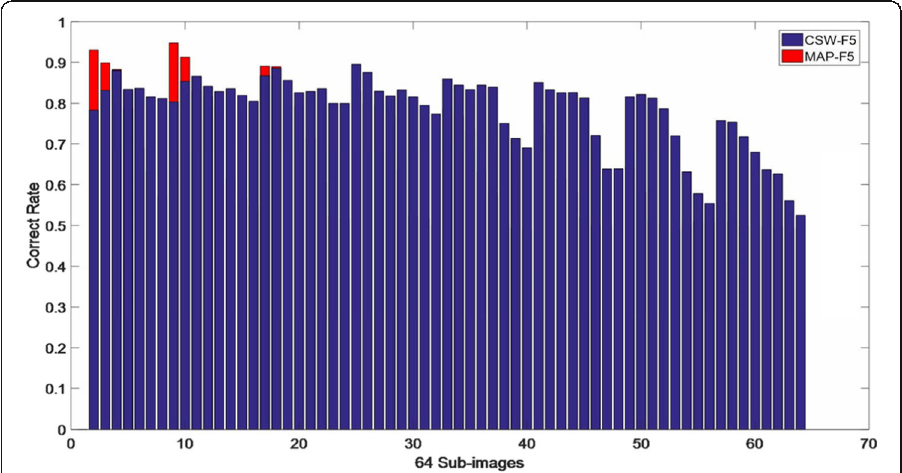
Fig. 7 Comparison of MAP-F5 and